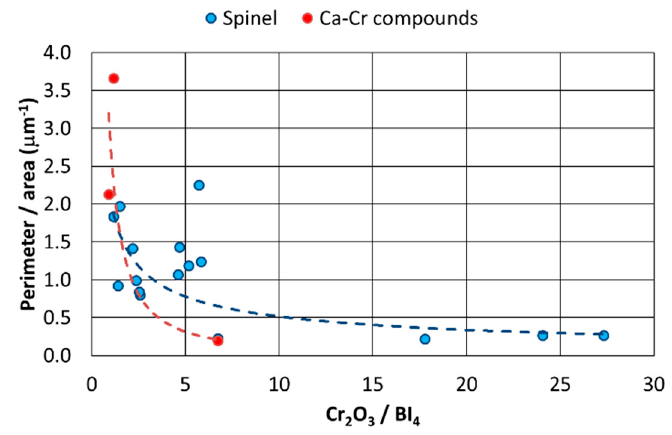
Figure 7. Examples of slag samples where overgrowth Cr-bearing phases coexist with small ones. ( a ) sample #19 ( b ) sample #8. Even the basicity has the same effect on the phase size (Figure 8). Thus, the combination of high chromium concentration with high basicity induces uncontrolled growth of oversaturated Cr-bearing phases. Large phases are characterized by low S/V ratio, which should help to reduce the leaching, since the dissolution rate should be low. Actually, during the standard test, the samples characterized by very large spinel (9,10,19–Figure 7a), leached low amount of Cr (less than 100 μ g/l). Probably, that leaching was only due to the small spinels that feature a high S/V ratio, and, in view of the consideration stressed above, are also unstable. Thus, that amount of leached Cr might be determined